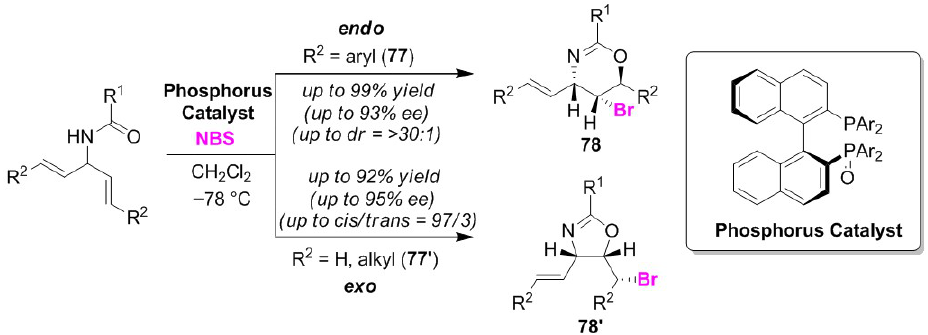
Figure 37. Selective synthesis of oxazines 78 and oxazolines 78 (cid:48) via the bromocyclizations of dienyl amides ( 77 and 77 (cid:48) ) using DTBM-BINAP monoxide.